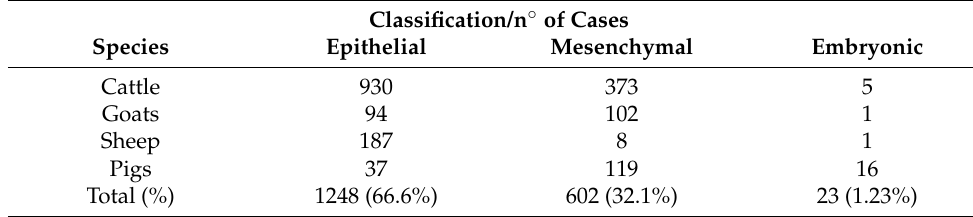
Table 3. Classification in epithelial, mesenchymal, and embryonic neoplasms.